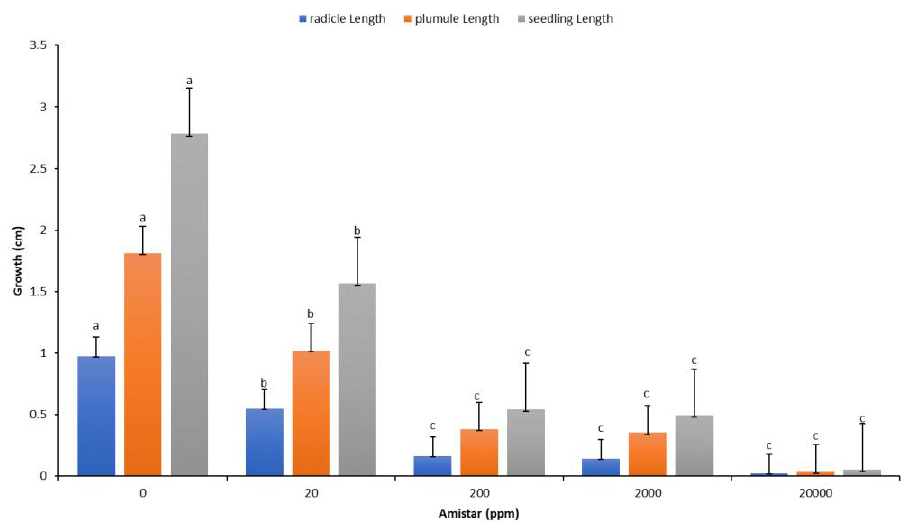
Figure 8. Response of radicles, plumules, and seedlings to different concentrations of antifungal. Values denoted with different letters are significantly different at p < 0.05.